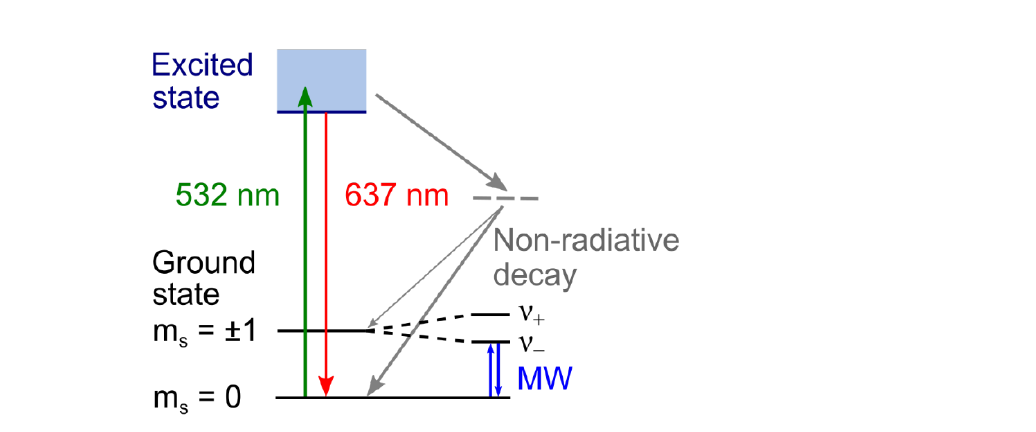
Figure A1. Energy-level diagram of the negatively charged NV center in diamond. The two magnetic sublevels with m S = ± 1 split due to the Zeeman effect. The zero phonon line of the NV center is at 637 nm.